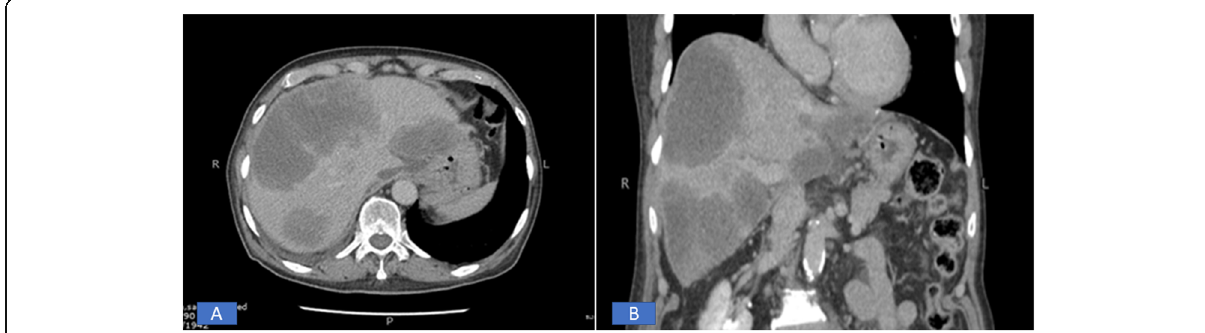
Fig. 1 a-b . CT scan images of transverse and coronal section showing multiple large hypodense deposits of varying sizes, in both lobes of